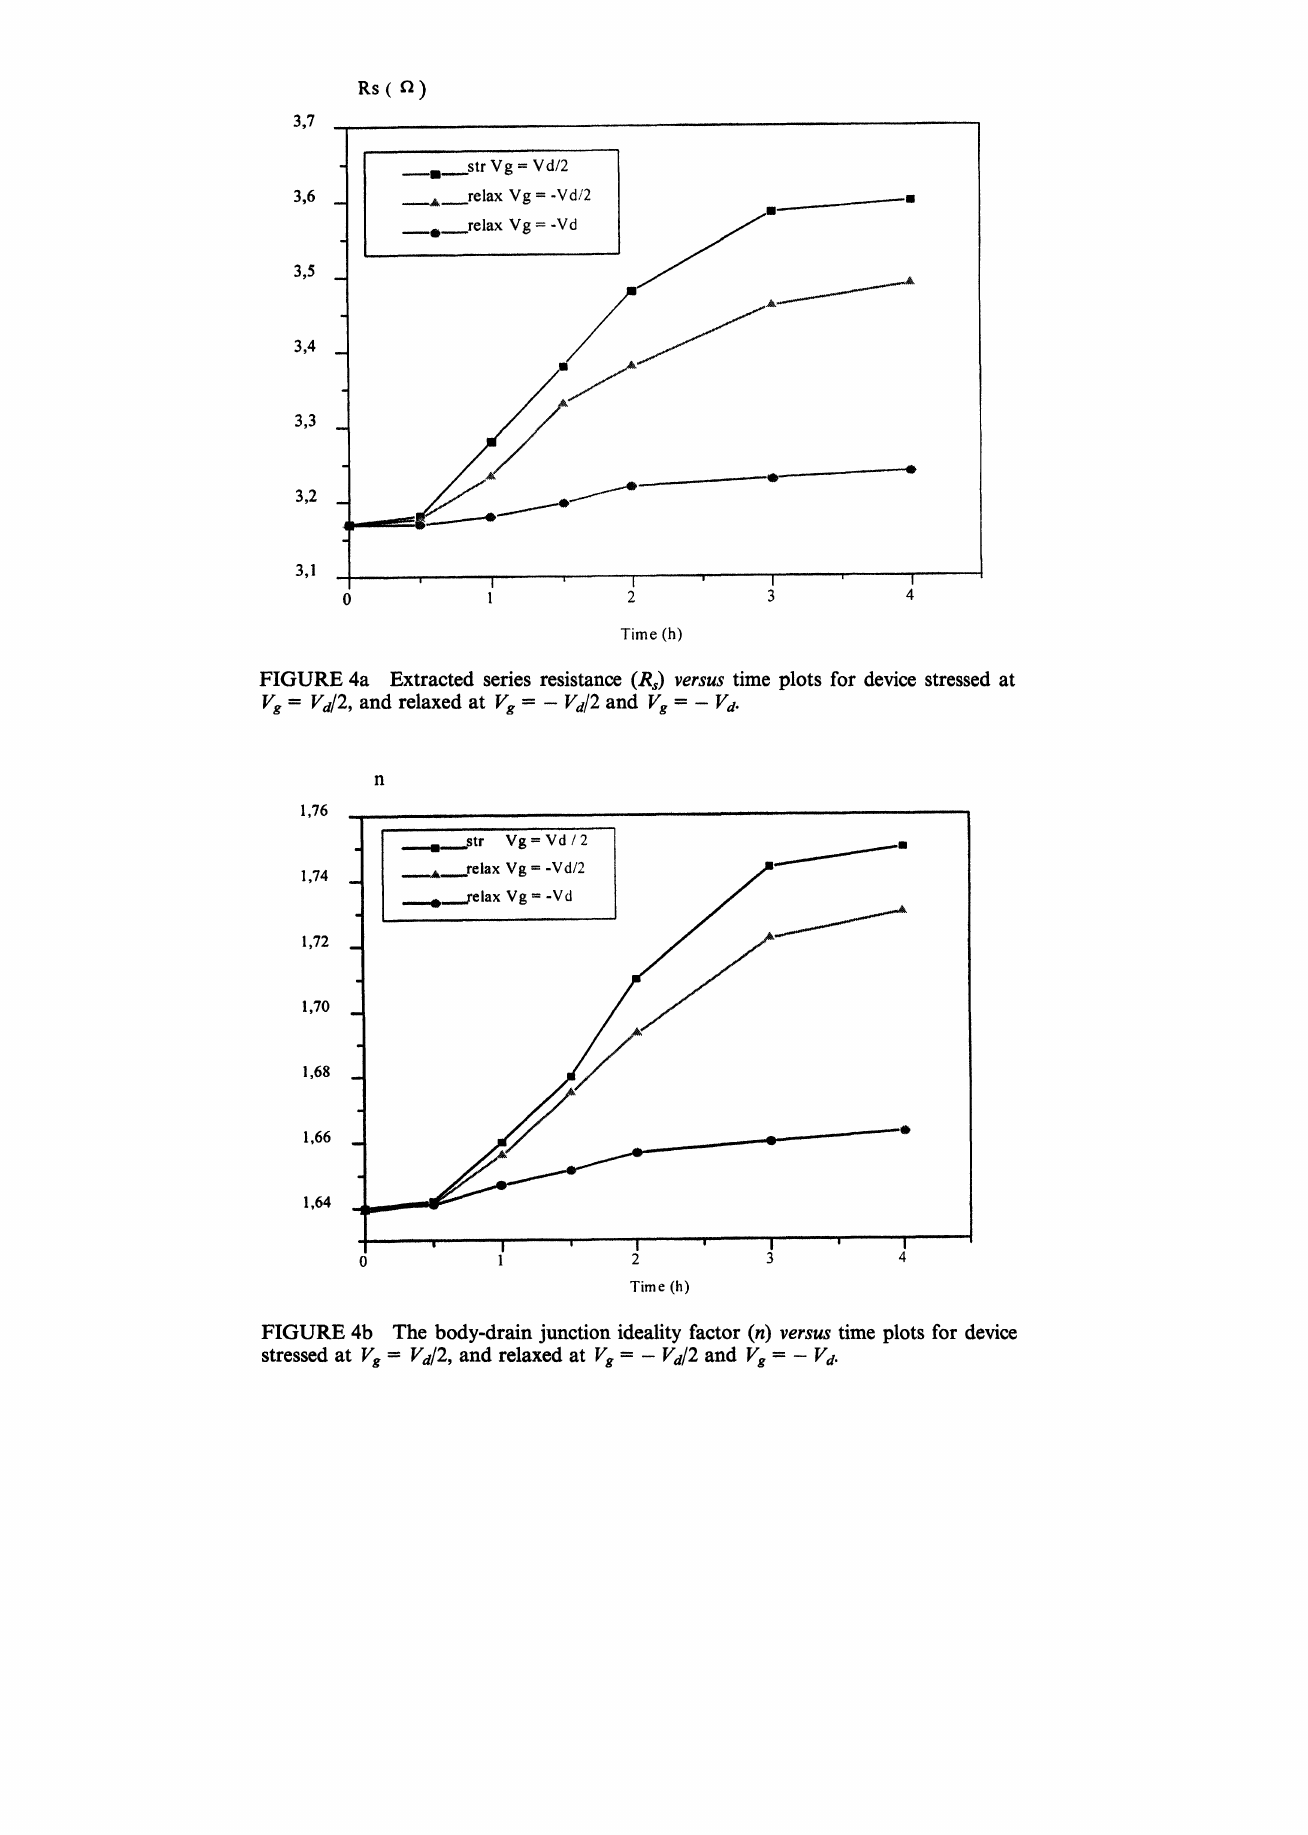
FIGURE 4a Extracted series resistance (Rs) versus time plots for device stressed at Vg Vd/2, and relaxed at Vg Vd/2 and Vg